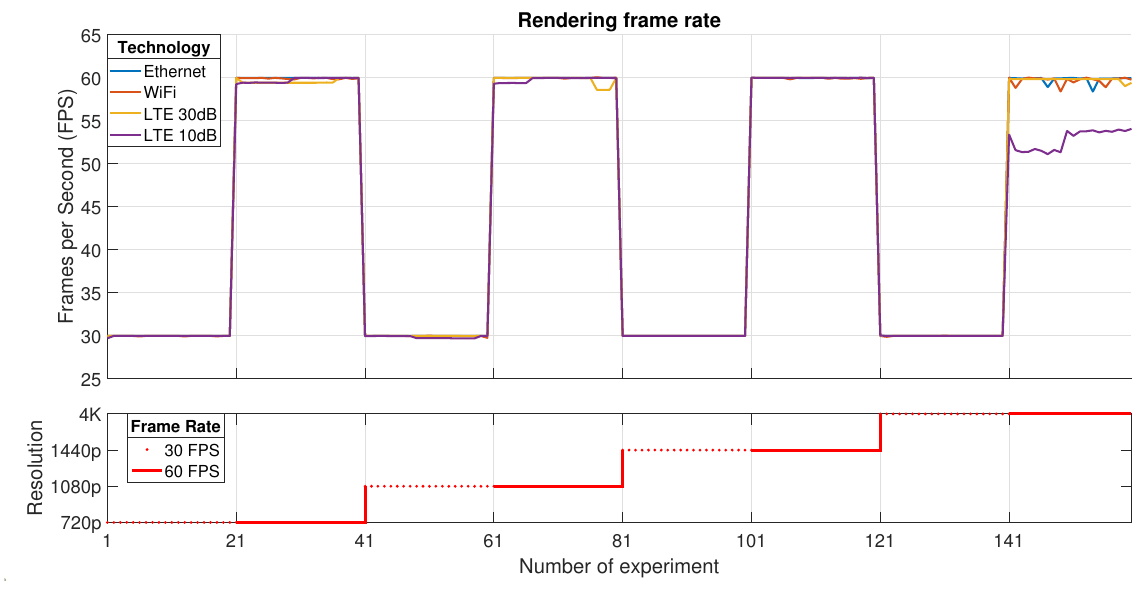
Figure 10. Rendering frame